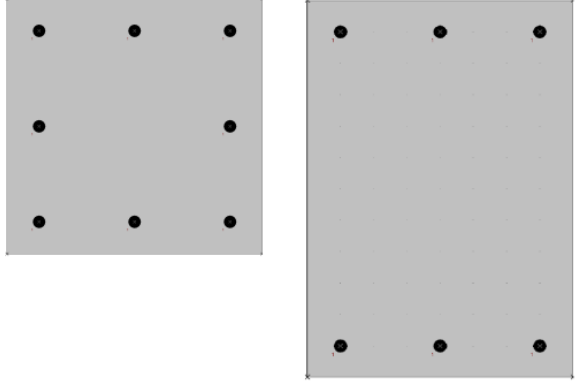
Figure 2. Cross-sections.